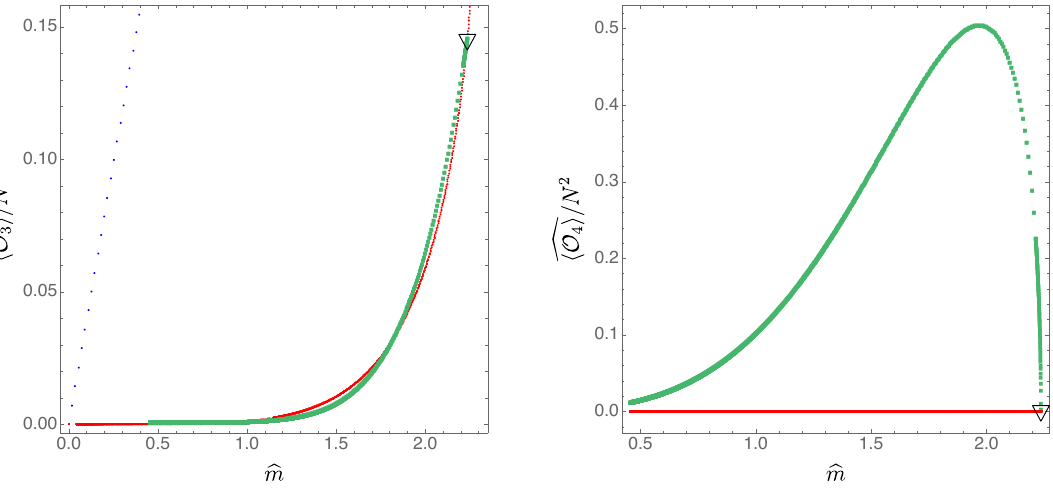
Figure 7 . The expectation values h b O 3 i (left panel) and h b O 4 i (right panel) as a function of The red and blue dotted solutions have (cid:27) = 0 (and thus h b O 4 i = 0), and were already displayed in the left panel of (cid:12)gure 4: here we zoom in the region of interest. On the other hand, the green squares represent the gaugino-condensate family of solutions with (cid:27) 6 = 0 hence h b O 4 i 6 = 0. The black inverted triangle O denotes the point of the merger of the two families at